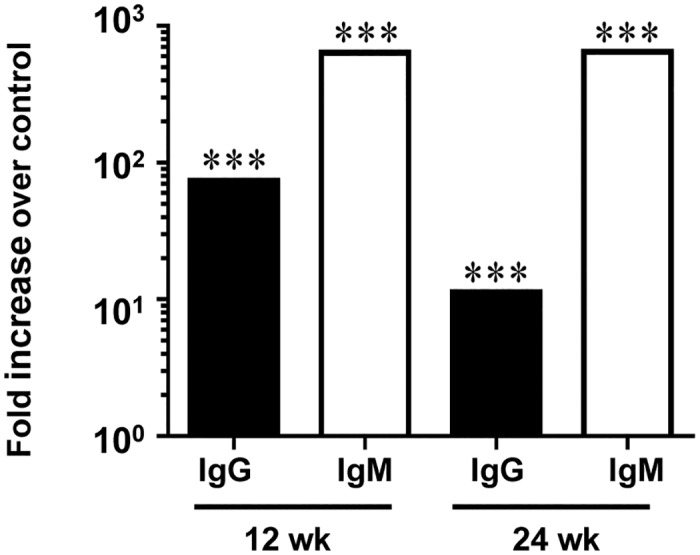
Chronic oral infection with F. nucleatum induced significant levels of serum F. nucleatum-specific antibodies.Graphs represent the fold-increase in F. nucleatum-specific IgG or IgM antibody titer in infected mice over control mice at both 12 and 24 weeks of infection. (*** P<0.001).